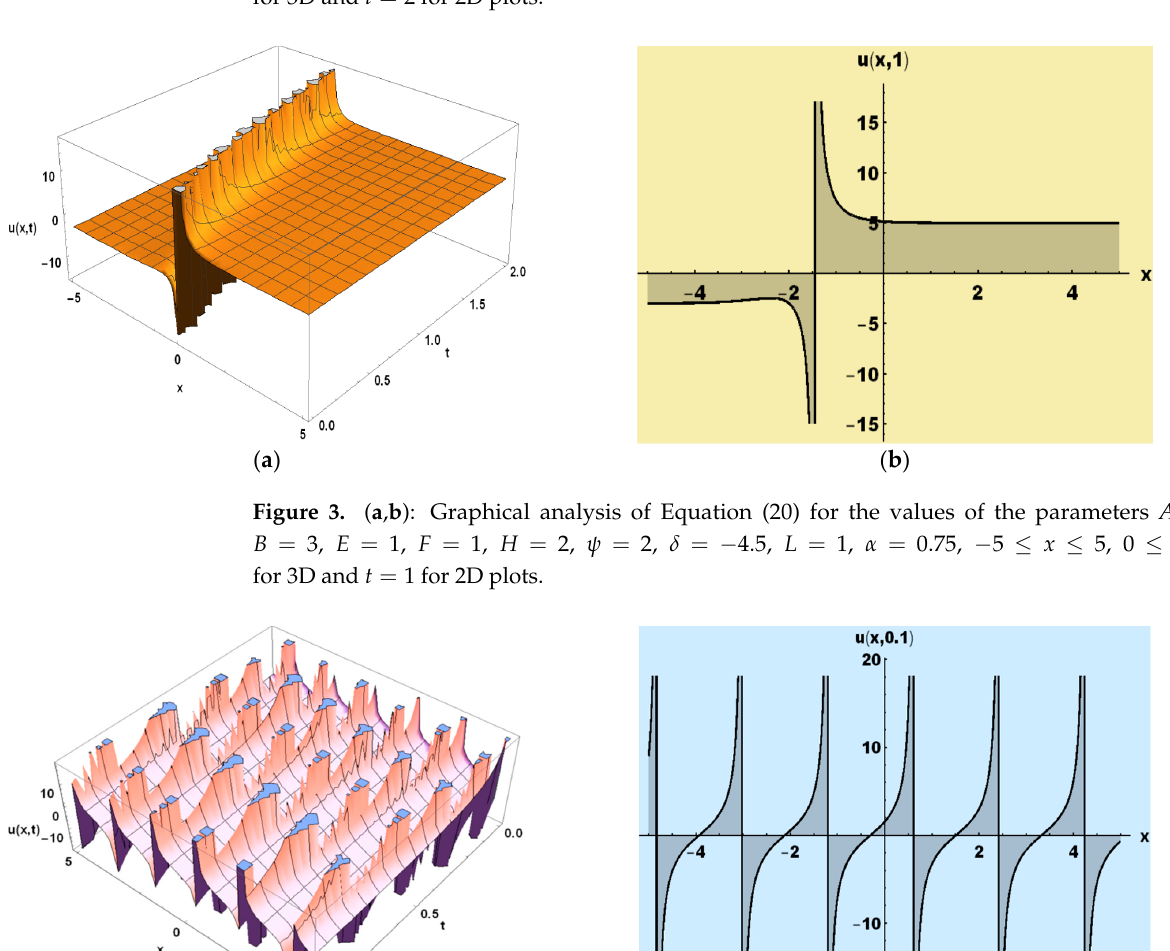
( b ) Figure 5. ( a , b ): Graphical analysis of Equation (22) for the values of the parameters ,1,1,2,2  FEBA 50,55,75.0,1,1,1,1  txLH  for 3D and 1  t for 2D plots.